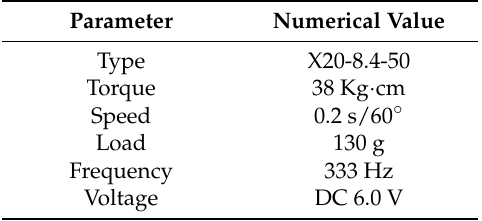
Figure 2. The structure of the automatic assembly system. Table 1. The parameters of the robot dynamics of the six joint servomotors.